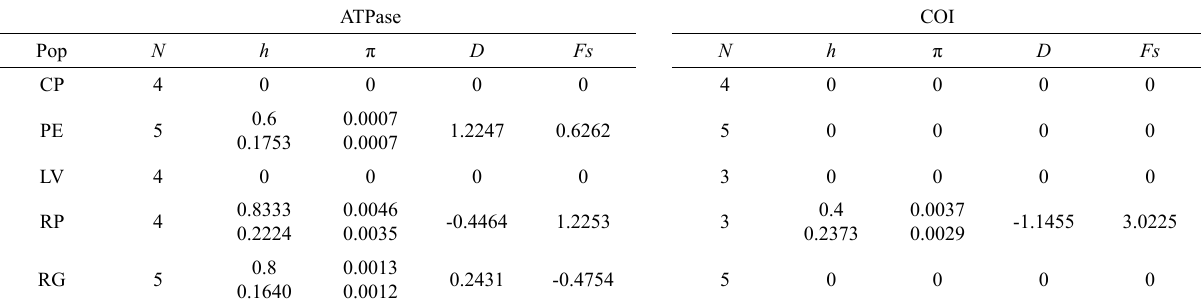
Table 5 – Values of genetic diversity and selective neutrality test of ATPase and COI for five populations of Psalidodon scabripinnis from the Serra da Mantiqueira region.